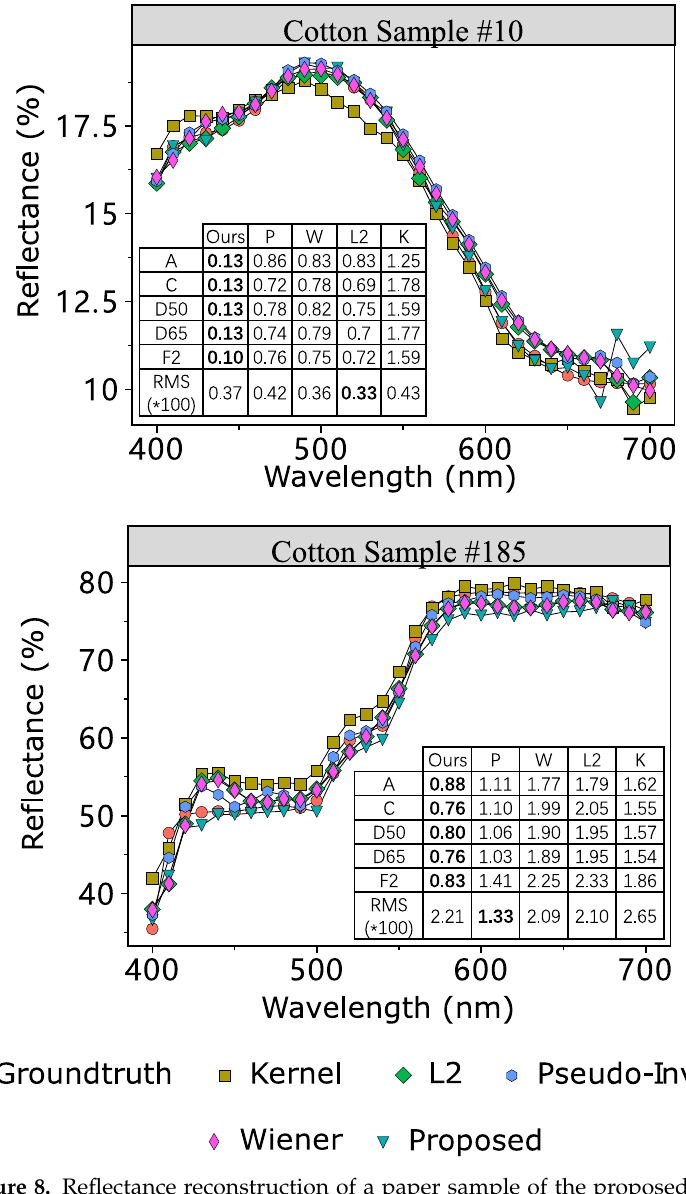
Figure 8. Reflectance reconstruction of a paper sample of the proposed L1-norm estimation and traditional estimations when using cotton for training. Tables inside the plots are the color difference and spectral difference. The A, C, D50, D65, and F2 represent different illumination. The unit of these items is ∆ E ( CMC ( 2:1 )) . RMS represents the Root-Mean-Square spectral difference metric. In the tables, method “P” is the briefcase of method Pseudo-Inverse. “Ours” is the proposed method. “W” is Wiener estimation. “K” means kernel